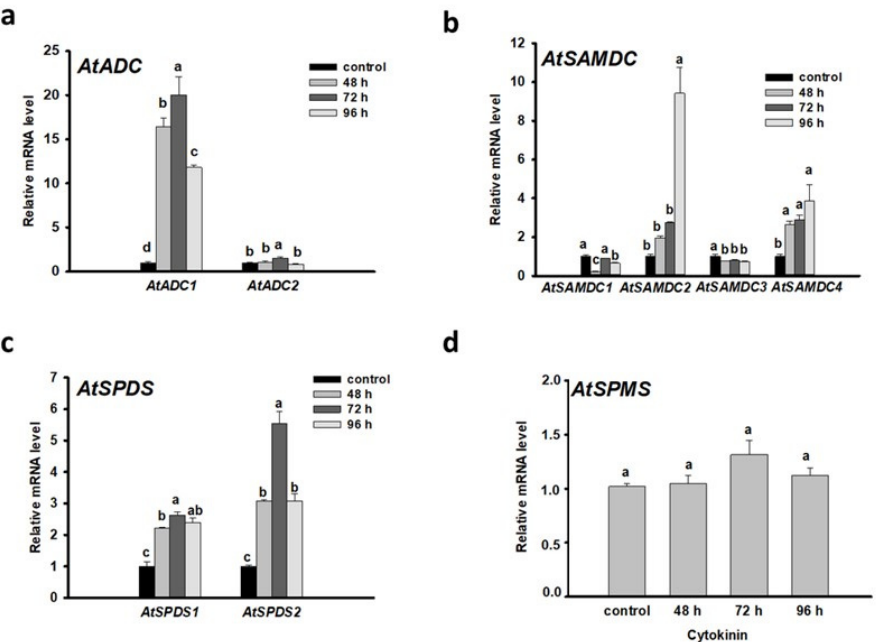
Figure 2. Expression of genes coding for enzymes involved in polyamine synthesis ( AtADC1-2 ( a ), AtSAMDC1-4 ( b ), AtSPDS1-2 ( c ), and AtSPMS ( d )) during the direct formation of shoot meristem from lateral root primordia (at the organ conversion (48 h), the early (72 h) and late (96 h) shoot promeristem phases [7]). The mRNA levels of the UBIQUITIN 1 (At3G52590) and PP2A3 (At1G13320.1) genes were used for gene expression normalization. The mRNA level of the untreated root tissue was used as control (relative mRNA level: 1). Data were averaged from three independent biological experiments with three technical replicates each. Standard errors are shown on the columns. The significance of difference between sets of data was determined by one-way analysis of variance (ANOVA) following Duncan’s multiple range tests; a p -value of less than 0.05 was considered significant as indicated by different